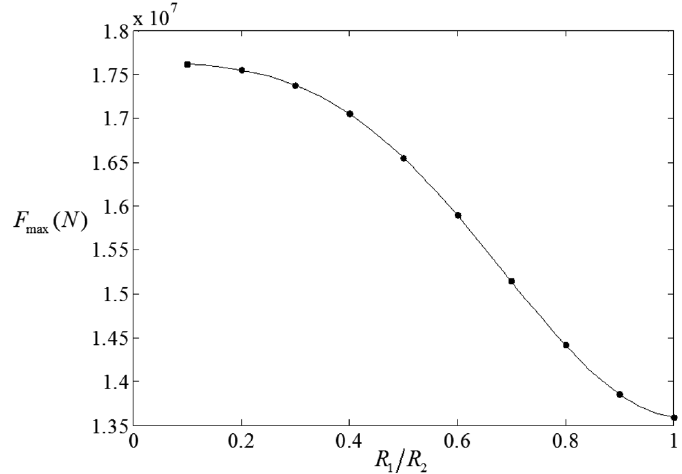
Fig. 14. Maximum amplitude in the time history of the resultant hydrodynamic force under the Kobe seismic excitation versus R 1 / R 2 for h 1 / R 2 = 0.4. the bottom versus R 1 / R 2 for h 1 / R 2 = 0.4 are illustrated in Fig. 16. The maximum amplitude in the time history